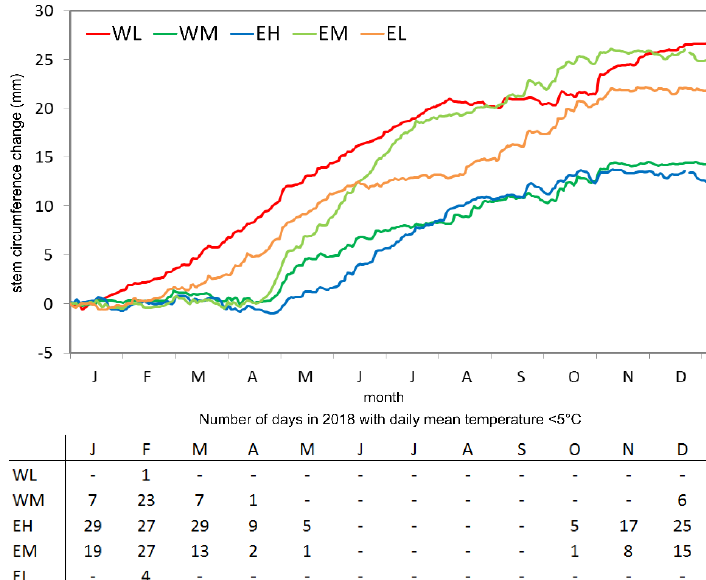
Figure 3. Mean cumulative stem circumference changes from the five study sites for the year 2018 reported as daily mean values from all trees (6 at WL, EH and EL, 12 at WM and EM) per site. Site codes refer to the east (E) and west (W) sides of Corsica, L, M, and H stand for low-, middle-, and high-elevation sites, respectively. The inserted table indicates the number of days in 2018 with daily mean temperatures <5 °C per site. Data gaps from our own climate stations are filled with data from nearby MétéoFrance climate stations [34].